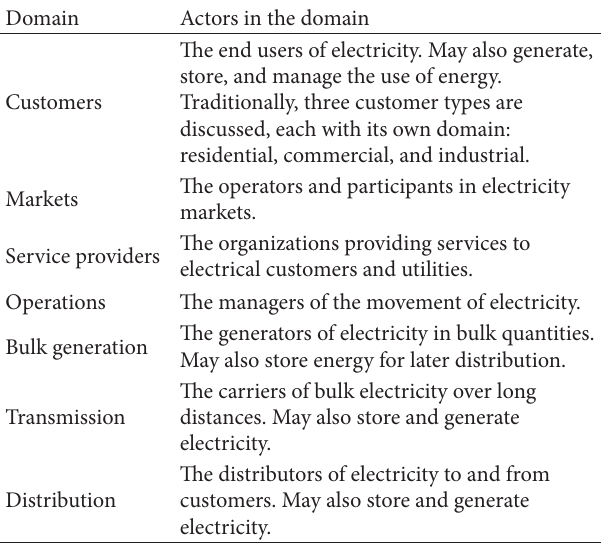
Table 1: Domains and actors in the smart grid conceptual model, based on [13, Table